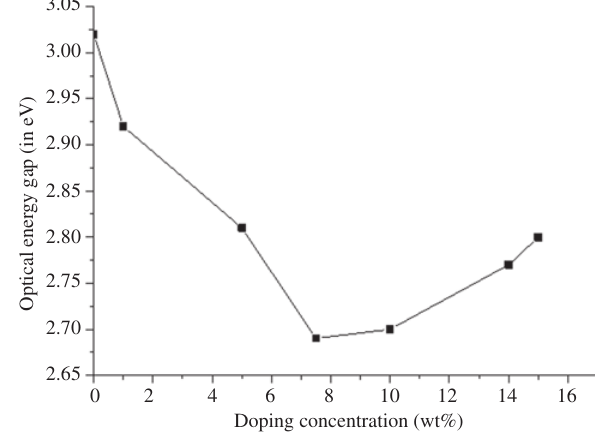
Figure 6: Variation of optical energy gap with doping